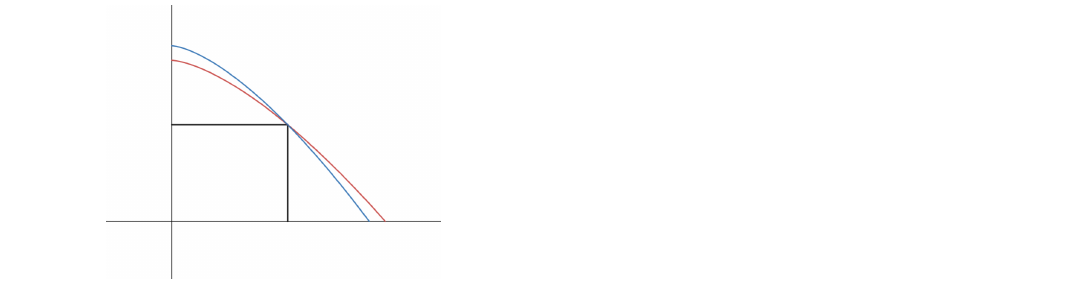
Figure 2. With the same parameters as in Figure fig:family, the curve in blue with a ≈ 0.44 minimizes the length and the curve in red with a = 10